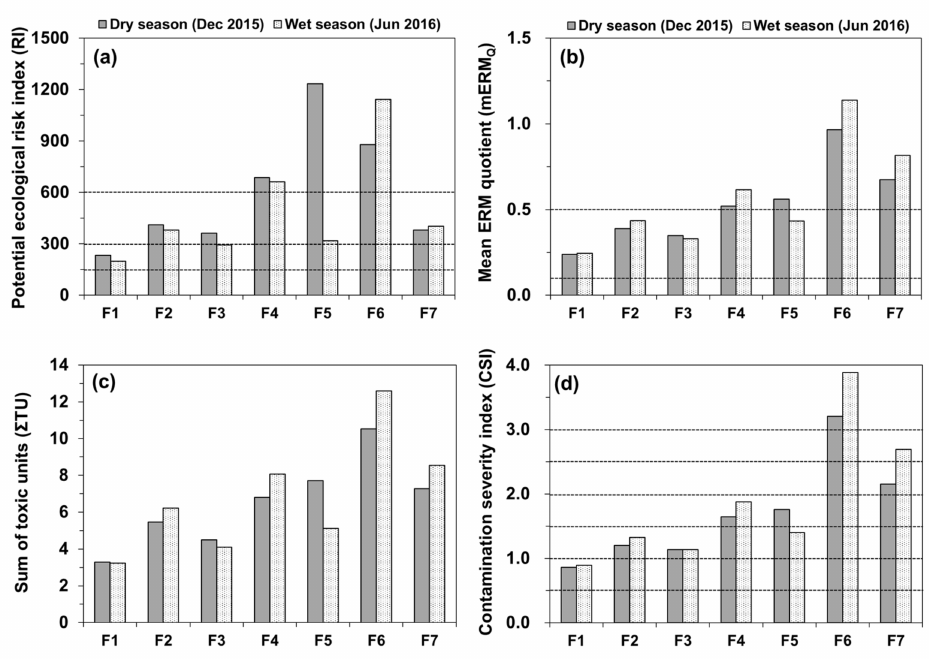
Figure 4. ( a ) Potential ecological risk index (RI), ( b ) mean ERM quotient (mERM Q ), ( c ) the sum of the toxic units ( Σ TU), and ( d ) contamination severity index (CSI) for heavy metals (As, Hg, Cr, Cu, Ni, Pb, Zn) in the sediments of Fengshan River. The RI is classified into low (<150), moderate (150–300), considerable (300–600), and very high ecological risk (>600); the mERM Q is classified into 9%